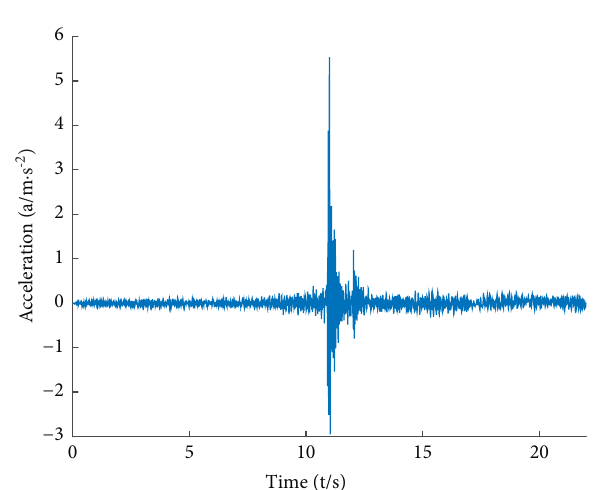
Figure 11: Time series of calculated vertical acceleration at hinge point.